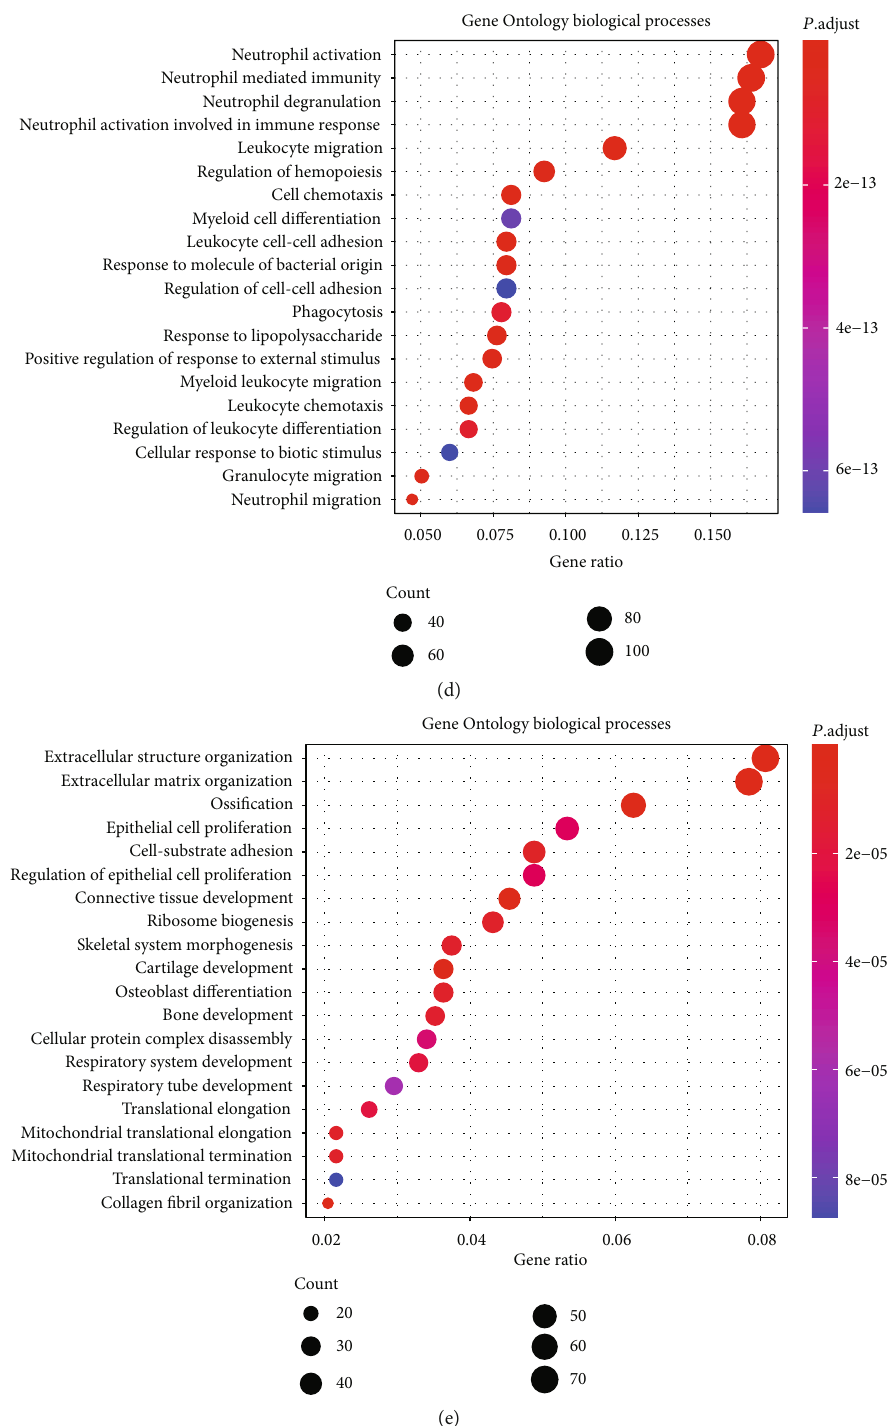
Figure 5: Gene expression comparison between monocytes and macrophages in the OA tissue. (a) Volcano plot comparing the gene expression between monocytes and macrophages in the healthy tissue. (b) Volcano plot comparing the gene expression between monocytes and macrophages in the OA tissue. (c) Dot plot showing the enrichment of Gene Ontology biological processes in the downregulated DEG between monocyte-like cell and macrophage in the healthy tissue. (d) Dot plot showing the enrichment of Gene Ontology biological processes in the downregulated DEG between monocyte-like cell and macrophage in the OA tissue. (e) Dot plot showing the enrichment of Gene Ontology biological processes in the upregulated DEG between monocyte-like cell and macrophage in the OA